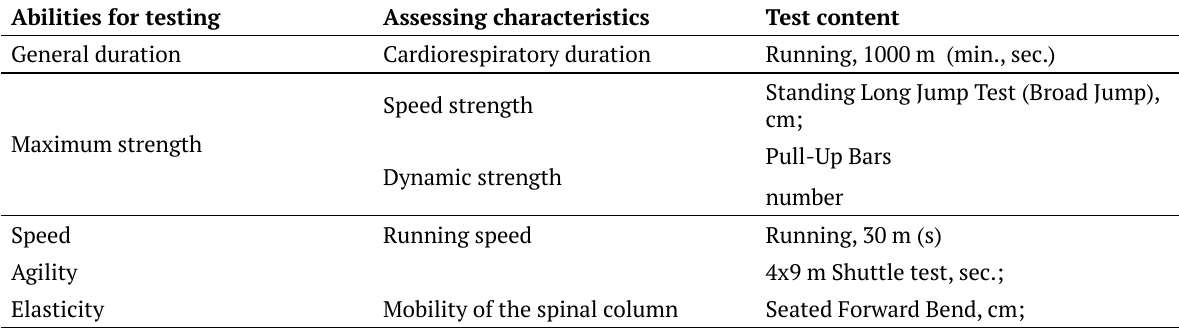
Table 2. Structure of the pedagogical testing system Abilities for